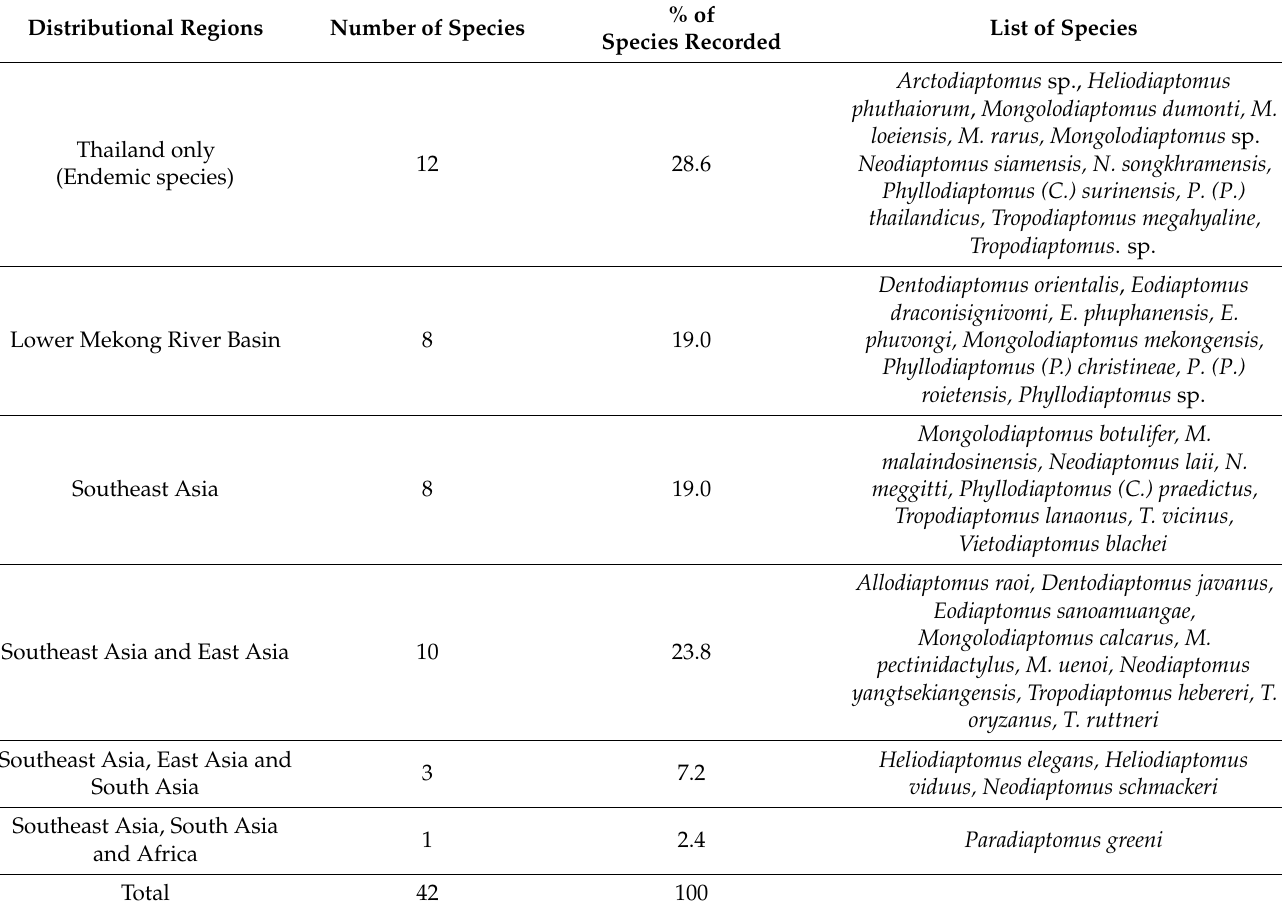
Table 4. Diaptomid copepods from Thailand are classified according to their general geographic distribution. The Lower Mekong River Basin region consists of Thailand, Myanmar, Laos, Cambodia, and Vietnam. The Southeast Asian region consists of Thailand, Myanmar, Laos, Cambodia, Vietnam, Malaysia, Singapore, the Philippines, Indonesia, and Brunei. The East Asian region consists of China, Japan, North Korea, South Korea, Mongolia, and Taiwan. The South Asian region consists of India, Sri Lanka, Afghanistan, Bangladesh, Bhutan, Nepal, and